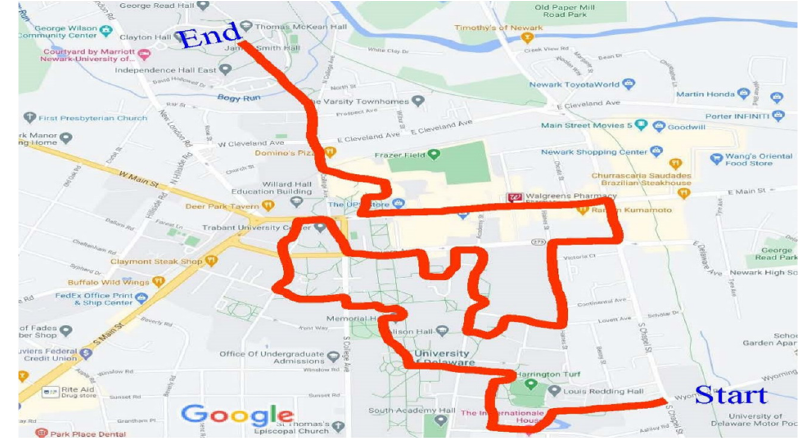
Figure 2. Map of route.